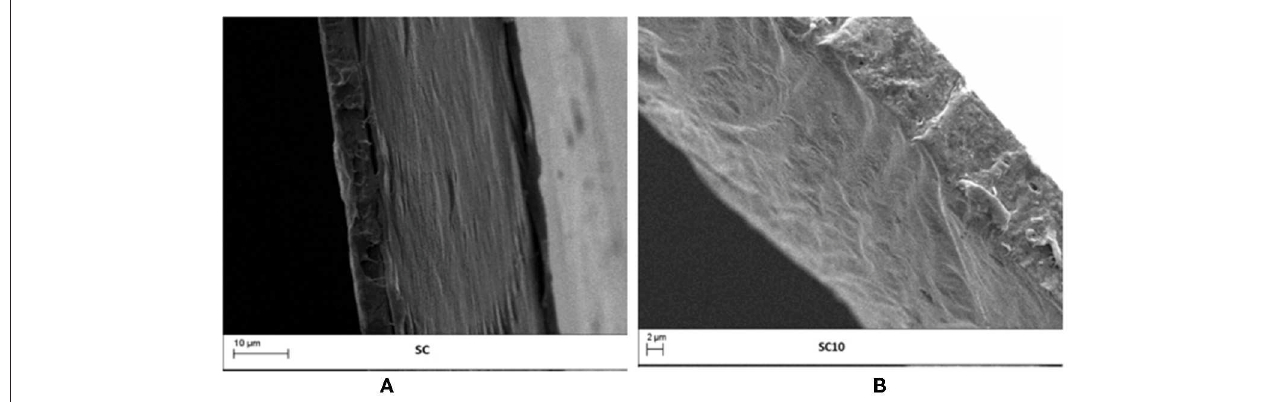
FIGURE 2 | Cross-sectional SEM micrographs of: (A) SC and (B) SC10 films.